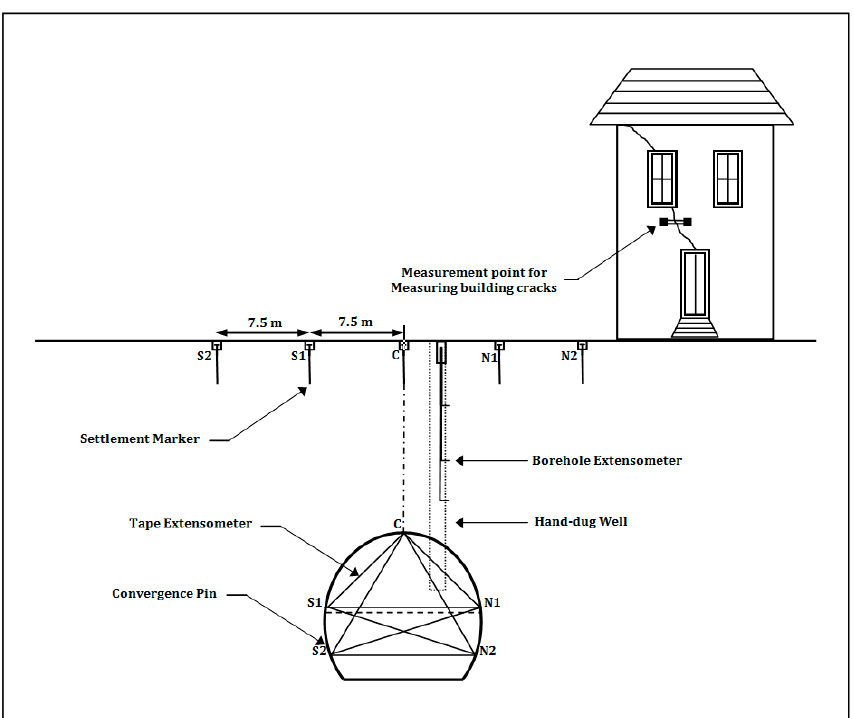
Figure 3. Typical monitoring plan in KUR project.